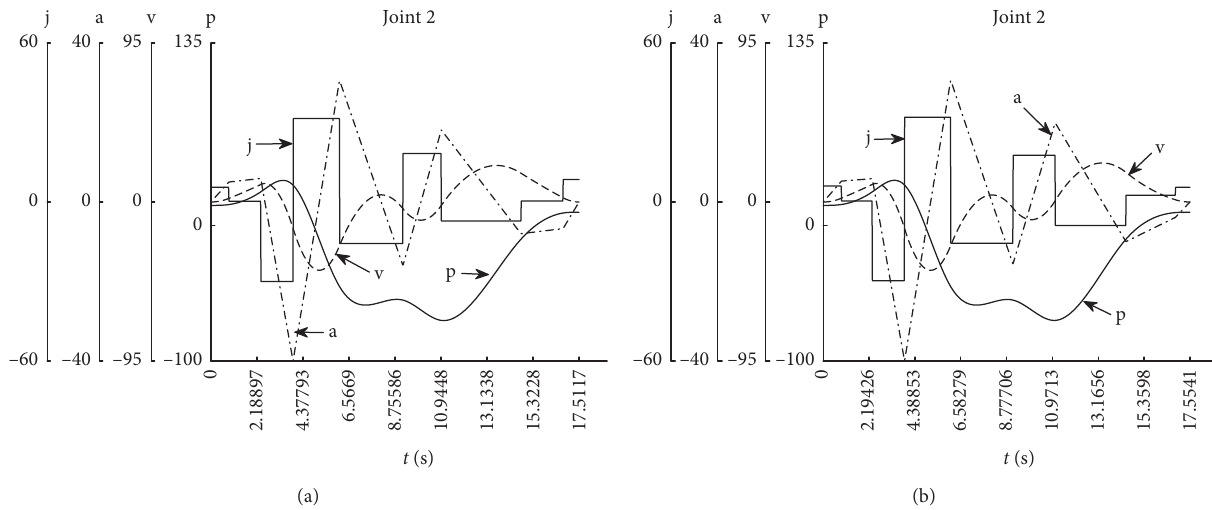
Figure 7: Trajectory result of single/dual-thread at Joint 2. (a) j / a / v / p plot with respect to time of the single-thread framework. The trajectory runtime equals to 17.5117 s. (b) j / a / v / p plot with respect to time of the dual-thread framework. The trajectory runtime equals to 17.5541s.